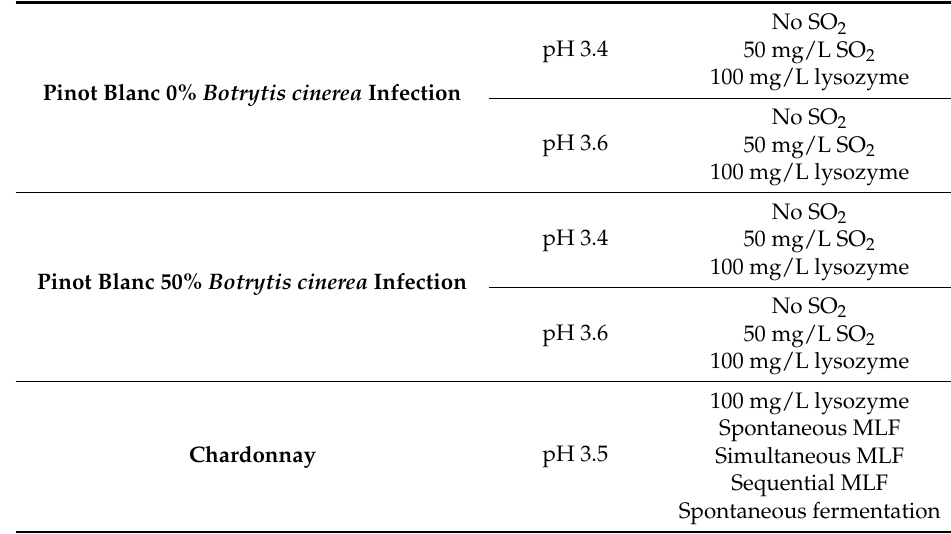
Table 2. Analytical data of grape musts prior to